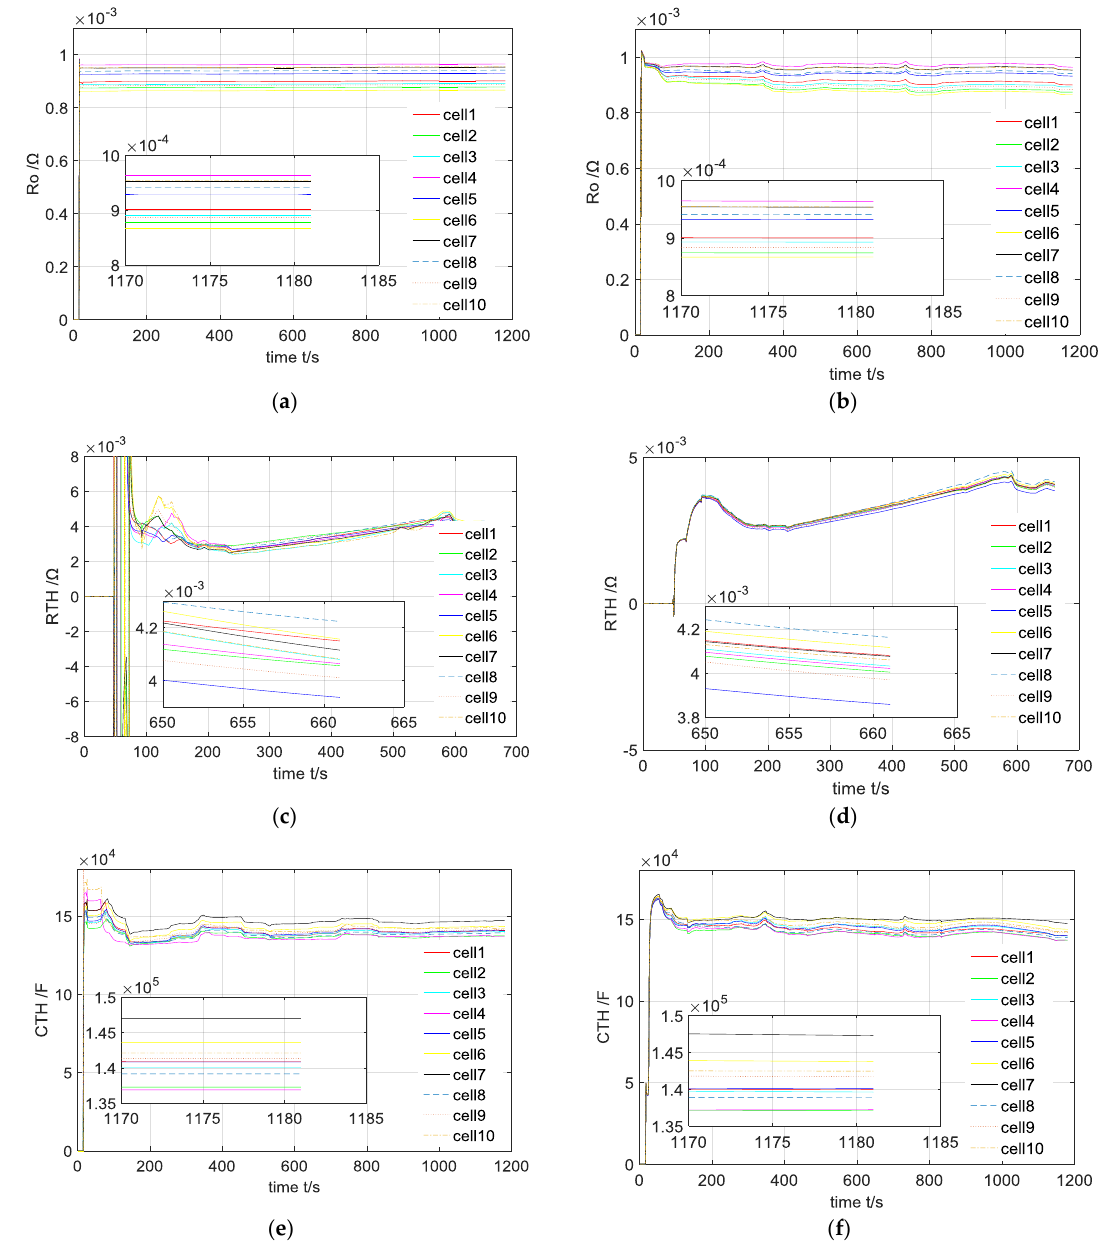
Figure 9. Identified parameters under the NEDC cycle test: ( a ) R O identified by the repetitive recursive least squares (RLS); ( b ) R O identified by the proposed new method; ( c ) R TH identified by the repetitive RLS; ( d ) R TH identified by the proposed new method; ( e ) C TH identified by the repetitive RLS; and ( f ) C TH identified by the proposed new method.